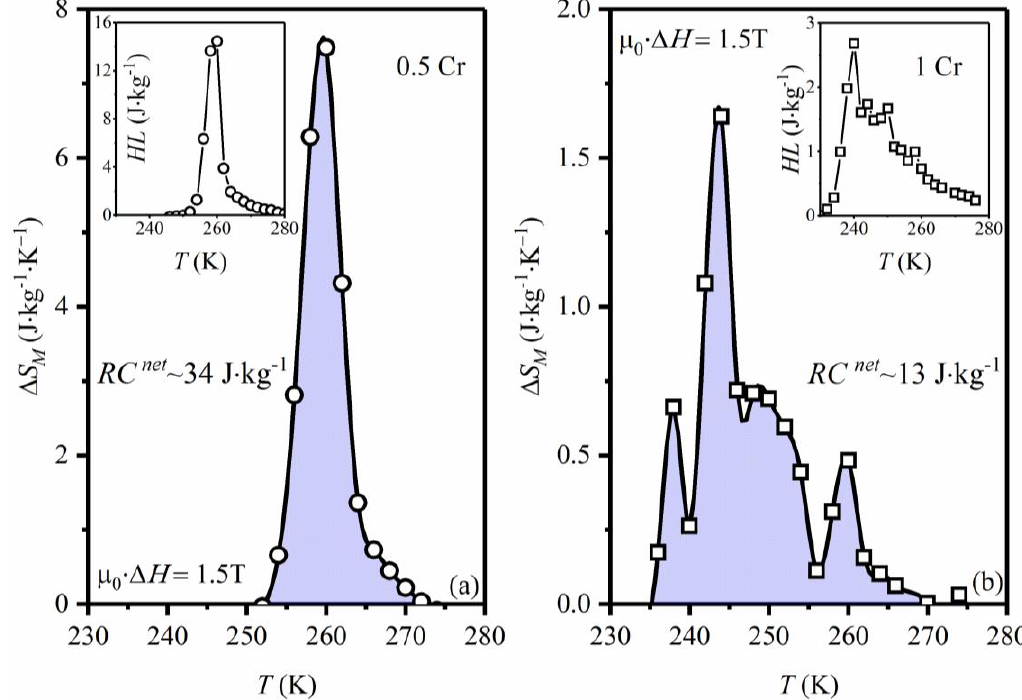
Figure 6. Temperature dependence of magnetically induced ∆ S M in the magnetic field of 1.5 T for the 0.5 Cr ( a ) and 1 Cr ( b ). Insets show the corresponding hysteresis loss ( HL ) related to the first order nature of MPT.